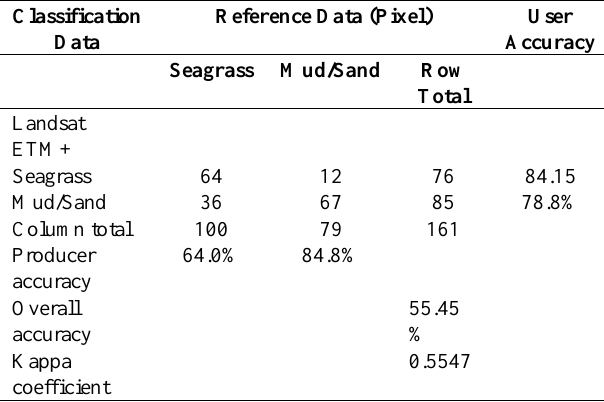
Table 3. Confusion matrix for classification of coastal features with BRI on Landsat ETM+ using MLC. The training samples set of an individual class derived from in-situ data were assigned for classifying the BRI layer.